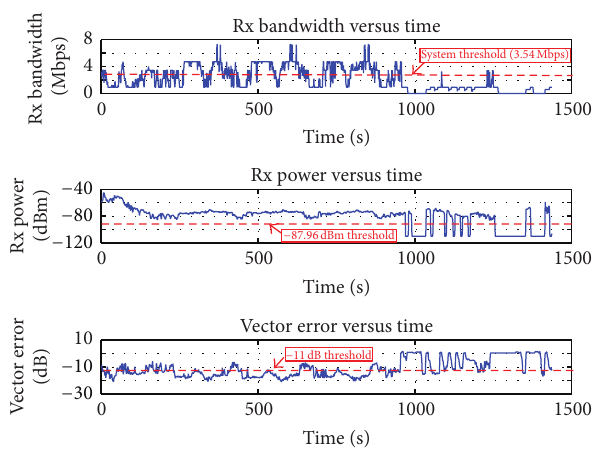
Figure 16: System bandwidth, Rx power, and vector error of MAB (random set fuzzy surface).